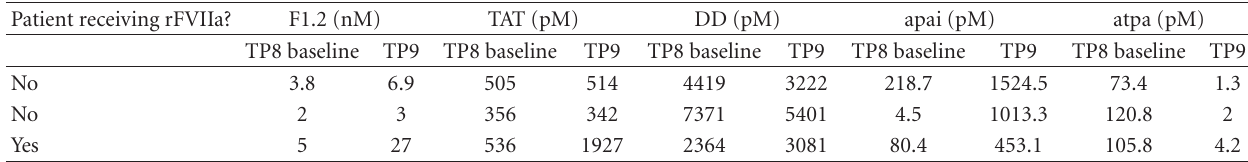
Table 1: Changes in Marker levels from before and after rFVIIa. nM: nanomolar. pM: picomolar. F1.2: prothrombin activation fragment. tat: thrombin antithrombin complex. dd: d-dimer. apai: active plasminogen activator inhibitor type 1. atpa: active tissue plasmingoen activator. TP8: Time point 8, after protamine or baseline for this report. TP9: Time point 9, 1 hour after surgery or after rFVIIa, if